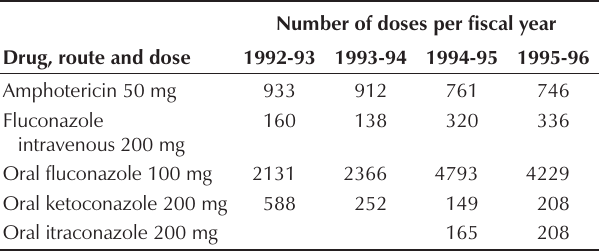
Use of antifungal drugs at Foothills Hospital, Calgary, Alberta, 1992 to